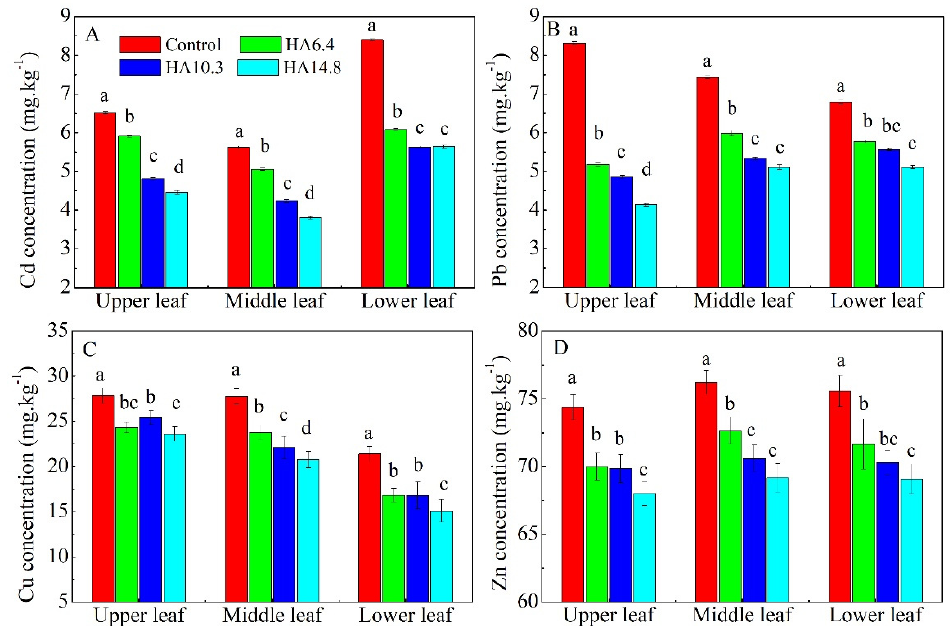
Figure 3. The contents of Cd (A), Pb (B), Cu (C), and Zn (D) in different parts of tobacco leaves. Lowercase letters indicate significant differences among Cd, Pb, Cu, and Zn contents in the same part of the leaves ( p < 0.05). Bars represent standard errors ( n = 4).